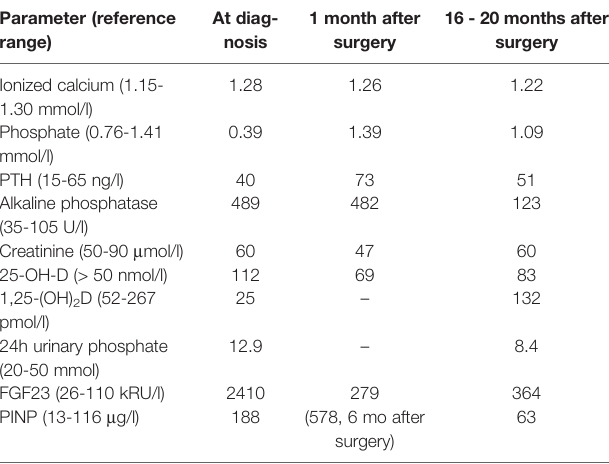
TABLE 1 | Biochemical fi ndings at diagnosis and 20 months after